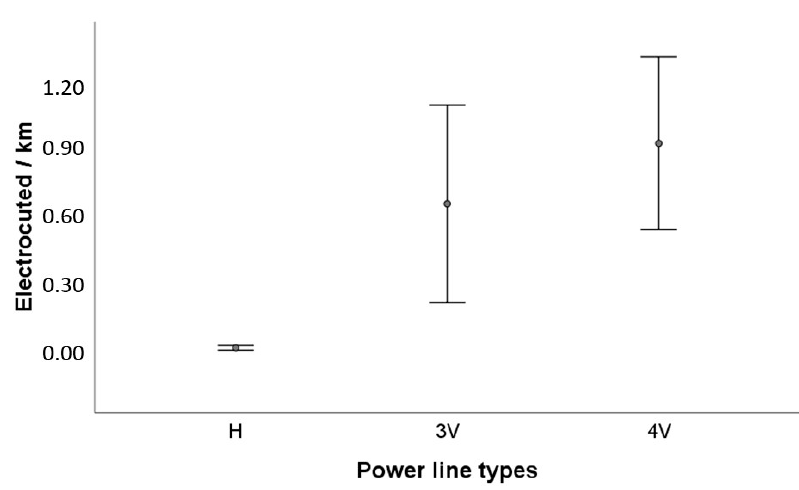
Figure 4. Averaged means (and 95% CI) of electrocuted flying foxes per km in 352 power lines according to their three types (H: horizontal wires; 3V: 3 vertical wires; 4V: 4 vertical wires).